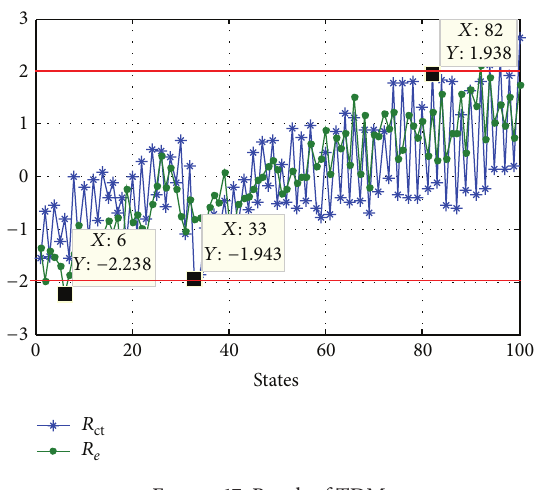
Figure 17: Result of